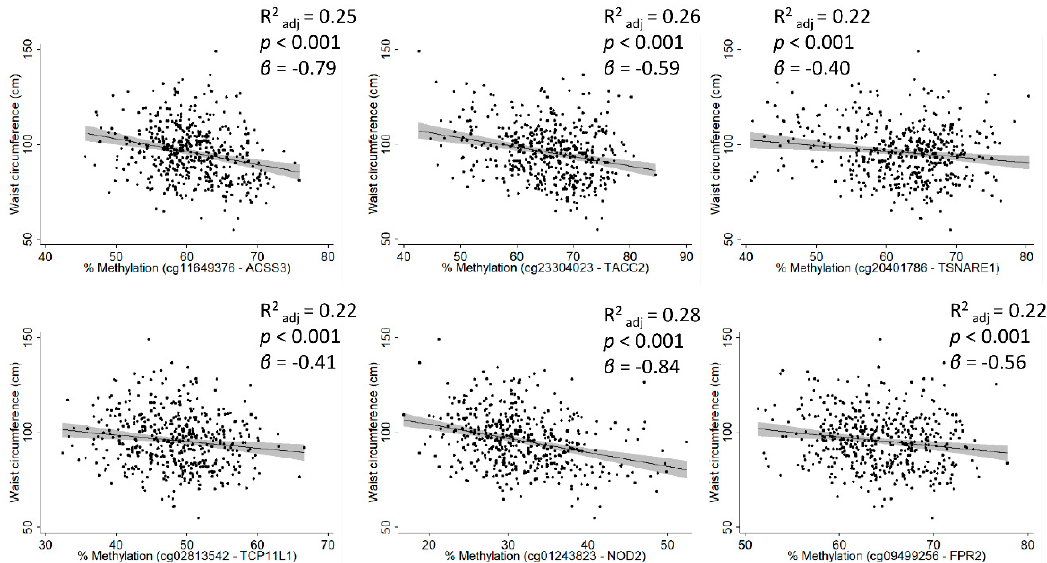
Figure 2. Linear regression graphs adjusted by sex and age representing the association between waist circumference and methylation β values of top six CpGs (corresponding gene according to Illumina) selected by a slope ≥ | 0.1 | and false discovery rate < 0.05. The grey stripe represent a 95% confidence band. Participants were classified according to sex and WC, separating females with WC ≤ 88 and > 88 cm, and males with WC ≤ 102 and > 102 cm, in order to analyze whether methylation was differential between both groups for each sex. There were 121 females with WC ≤ 88 cm and 182 with WC > 88